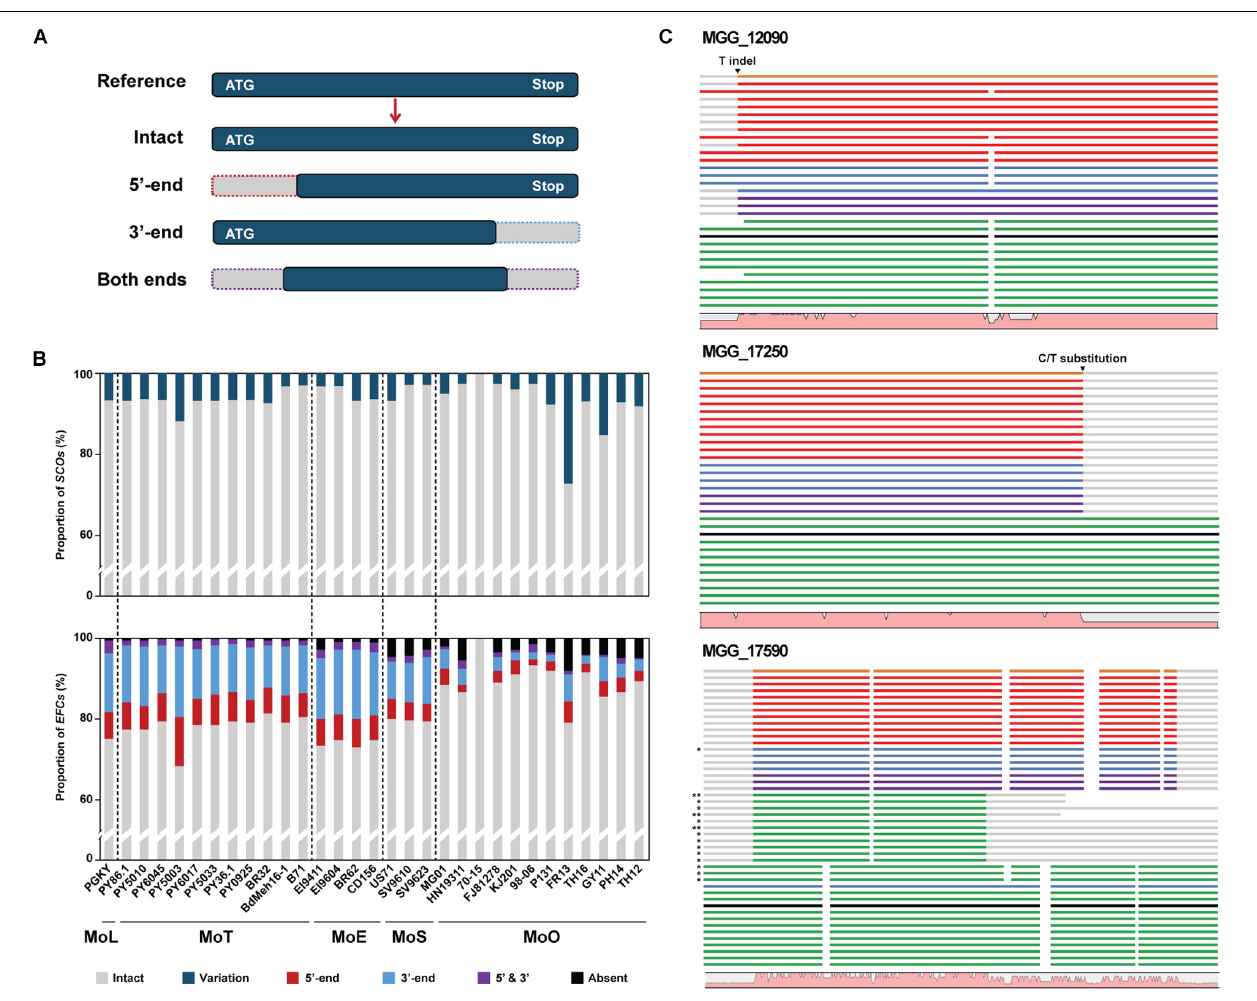
FIGURE 3 | Characteristics of the structural variations in the SCO and EFC genes in M. oryzae isolates. (A) A schematic diagram depicting the types of gene structural change found using Exonerate. (B) The proportions of SCO (top) and EFC (bottom) genes in each isolate are shown. The proportions of the SCOs with structural variation (teal) and the EFC s detected to be truncated at 3 (cid:48) -end (blue), 5 (cid:48) -end (red) or both ends (purple) are noted. The proportion of the genes absent is noted in black. (C) Three examples of structural variation observed in CDS, including 5 (cid:48) -end variation, 3 (cid:48) -end variation, and variation at both ends, are shown. The isolates in the alignments follow their order in the phylogenomic tree. The reference genes encoded by MoO 70-15 are labeled black, and their homologs encoded by MoO, MoS, MoE, MoT, and MoL isolates are labeled green, purple, blue, red, and orange, respectively. For MGG_17590, asterisks are used to indicate the second ( ∗ ) and third ( ∗∗ ) best hits. The graph at the bottom of each alignment shows the degree of sequence conservation. Their full sequence alignment is shown in Supplementary Figure 5